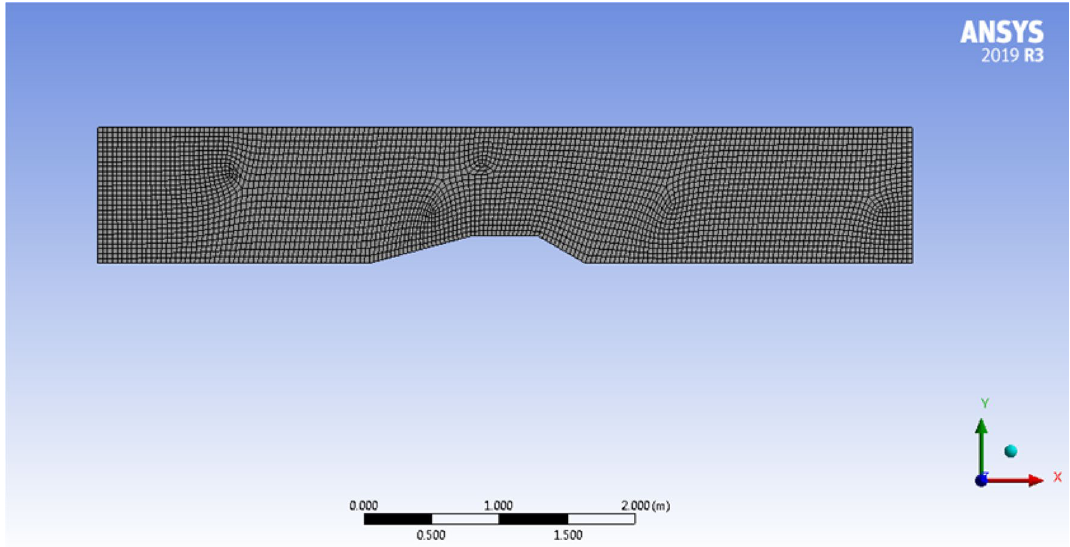
Fig. 2 The computational mesh